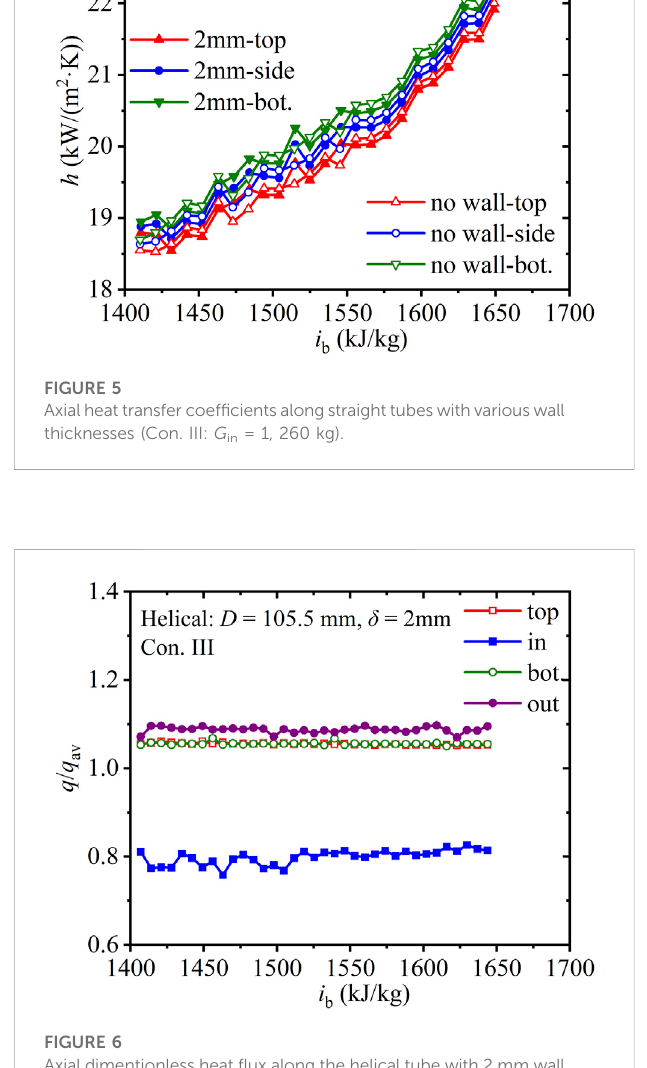
local heat fl ux to the average heat fl ux on the inner wall) of three